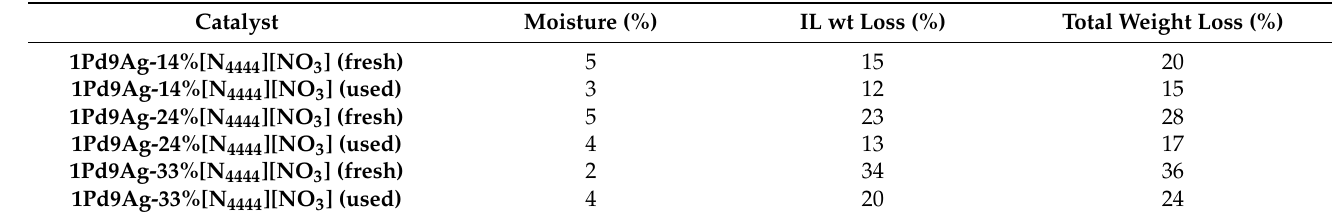
Table 3. Thermal analysis data for the fresh and used